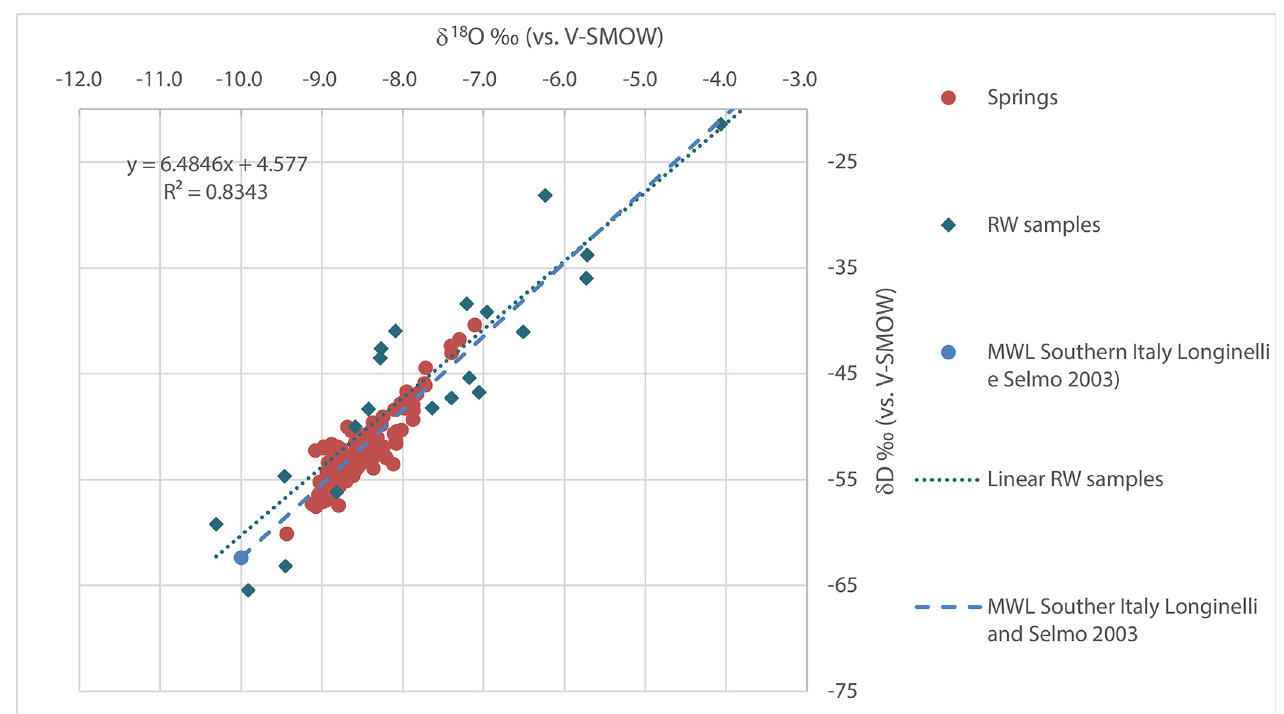
Fig 13. Relationship between δ 2 H and δ 18 O. The red dots represent the investigated waters and the black dots symbolize the isotopic signature of local rainwater. The dashed black line shows the local meteoric water line.